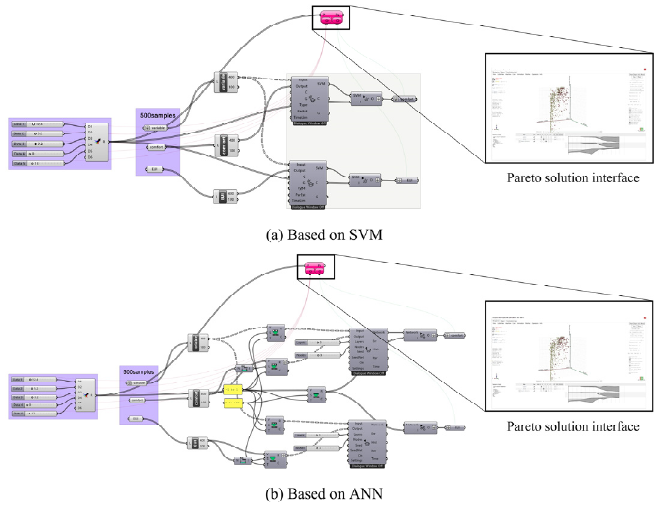
Figure 11. Multi-objective optimization operation battery